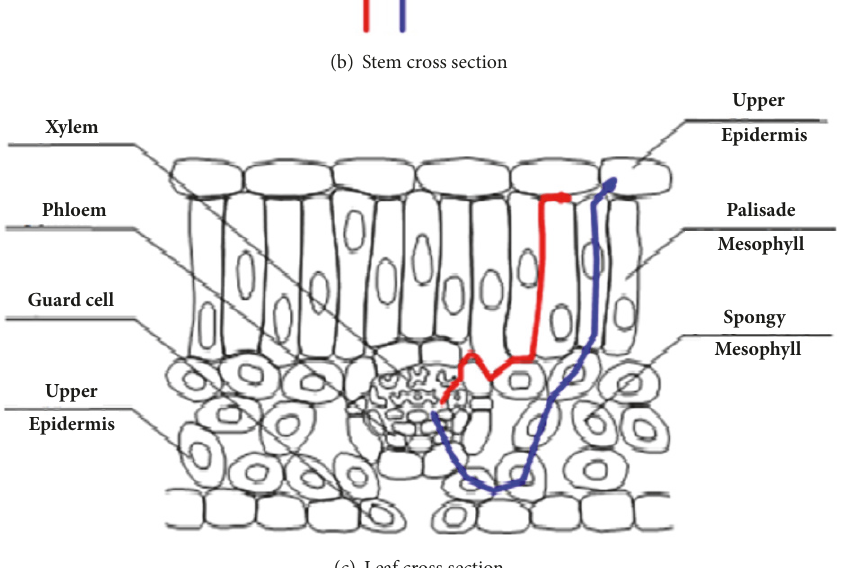
Figure 5: Diagram of apoplastic and symplastic pathways of Cd transport. The red and blue line show the apoplastic and symplastic pathway, respectively (source: Song et al. reprinted with